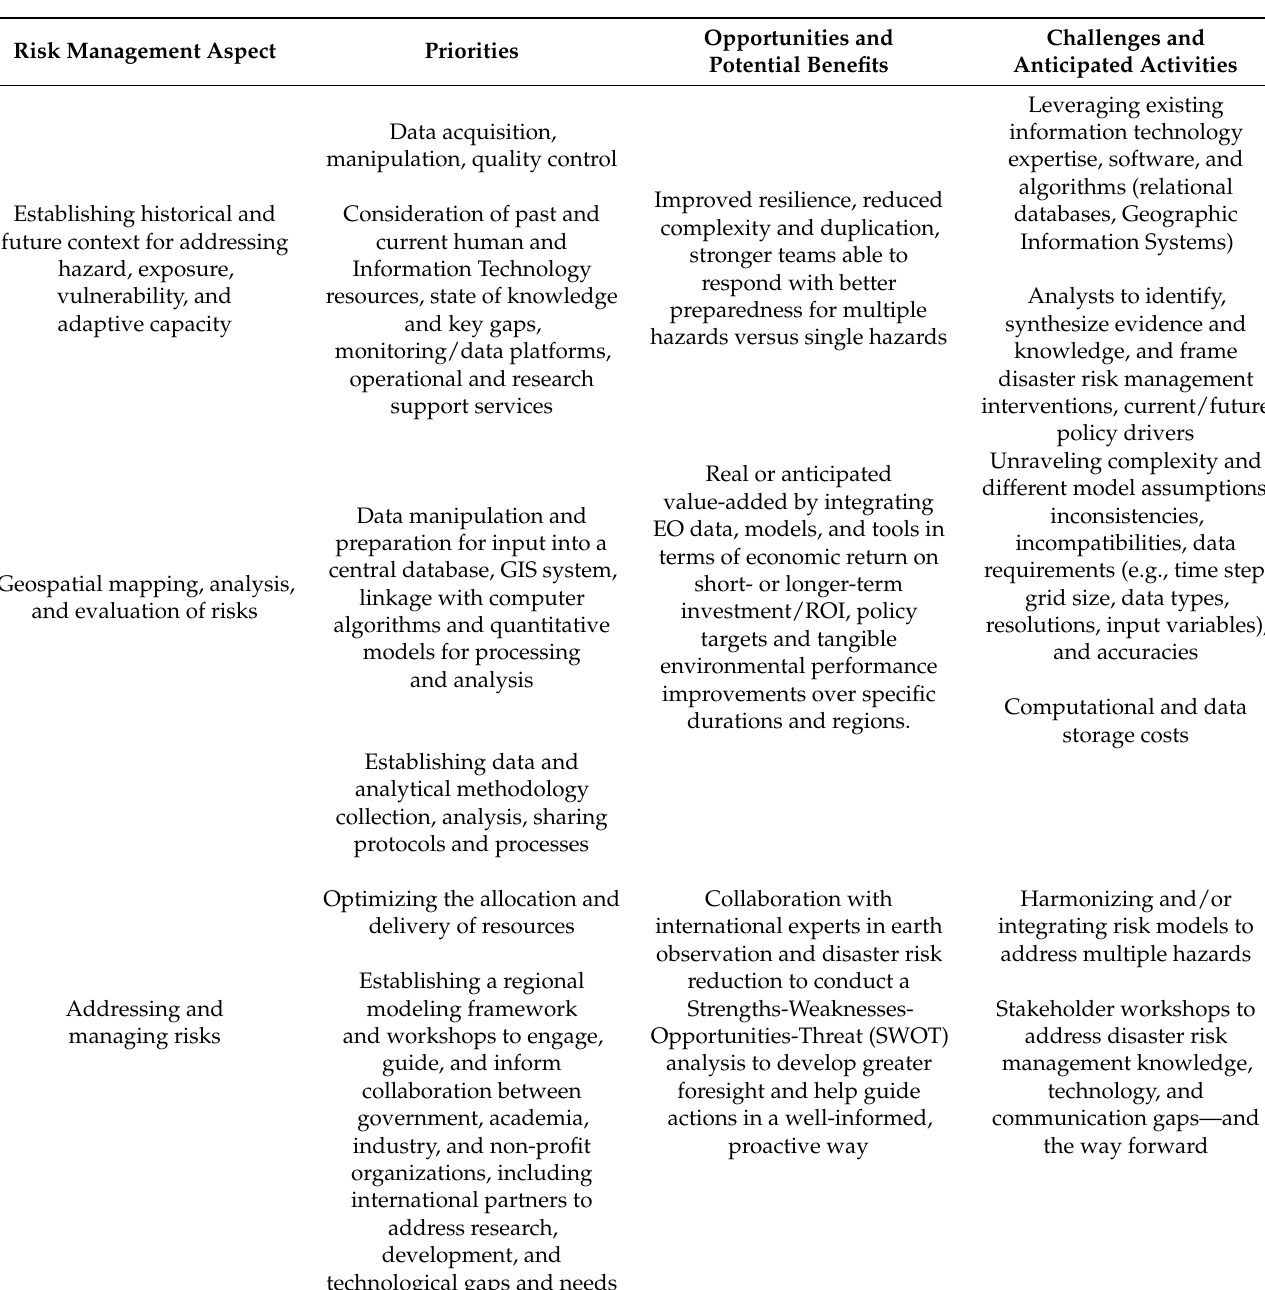
Table 3. Integrating EO data, models, tools into a national disaster risk management